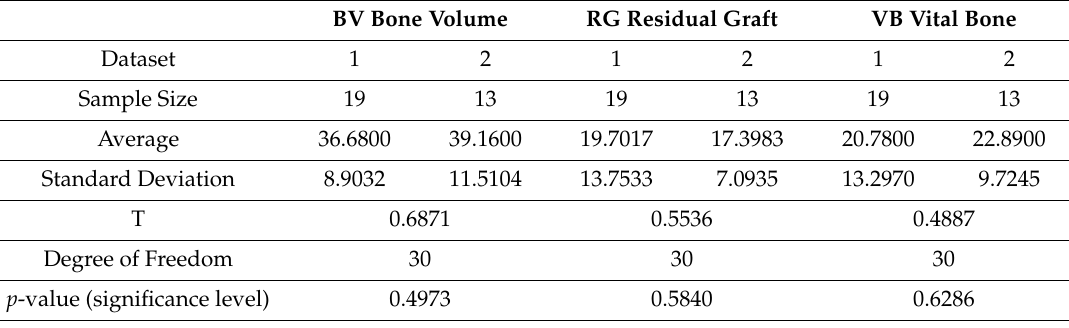
Table 5. Statistical analysis ( p > 0.005 denotes no statistical significance).